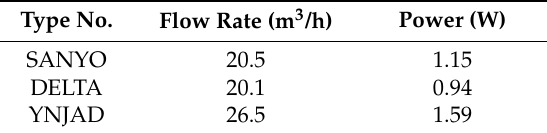
Table 6. Different types of cooling fan for optimization.